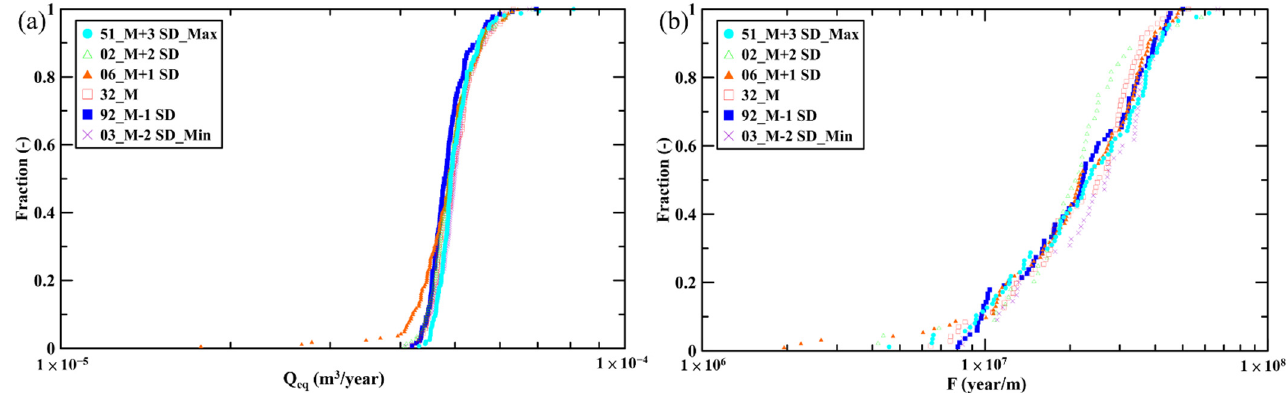
Figure 13. Q eq and F of the realizations relative to the statistical results of the effective fracture numbers. ( a ) The results of Q eq for the statistics of the effective fracture numbers; ( b ) The results of F for the statistics of the effective fracture numbers.